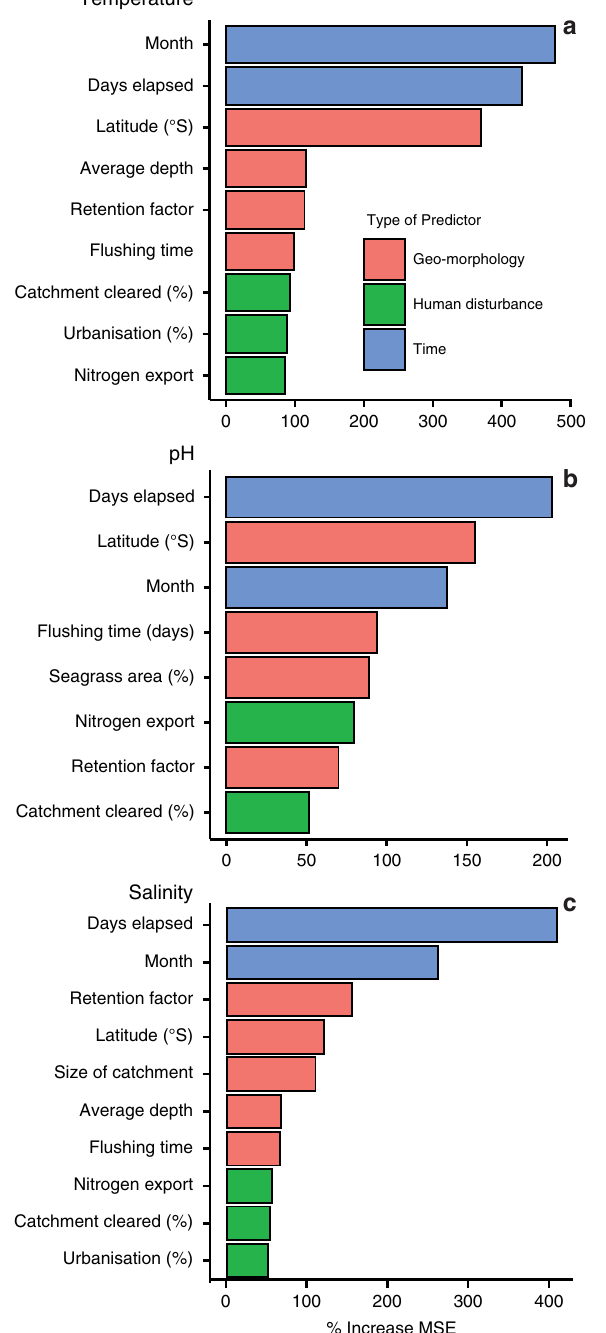
Table 3 Model validation